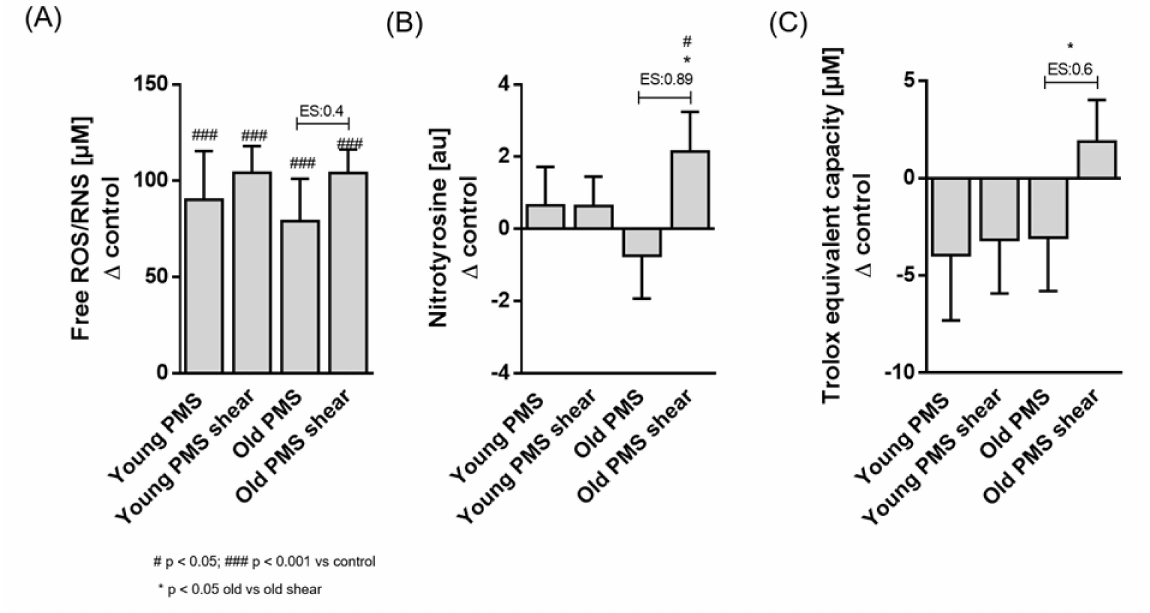
Figure 1. Markers of oxidative stress in old and young red blood cells (RBCs) after phenazine methosulfate (PMS) and/or shear stress application relative to baseline. ( A ) Free reactive oxidative and nitrosative species (ROS/RNS) levels were significantly higher in PMS-treated samples compared to the control condition ( p < 0.001) but comparable between young and old RBCs. Shear stress application additionally increased ROS/RNS levels in the old PMS-treated RBCs (effect size (ES) = 0.4). ( B ) Nitrotyrosine staining was not affected by PMS nor by shear stress in young RBCs, but the combination of shear stress and PMS application significantly increased nitrotyrosine signal in old RBCs compared to control and compared to non-sheared samples ( p < 0.05). ( C ) Antioxidant capacity, reflected by Trolox equivalent capacity, was lower in PMS-treated young and old RBCs. Shear stress significantly increased antioxidant capacity of old PMS-treated RBCs ( p <